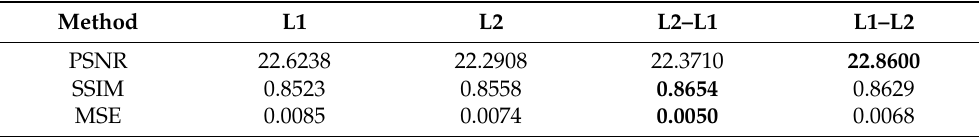
Table 1. Comparison of objective indicators using different training methods.